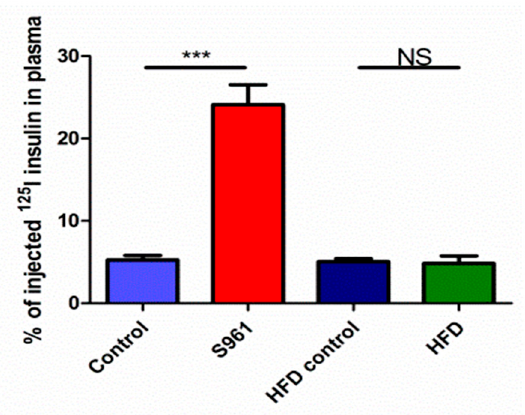
Figure 1. Plasma content of 125 iodine remaining in plasma at five minutes after injection in animal studied under protocol 1 (left two bars) and protocol 2 (right two bars). *** Indicates p value less than 0.001 unpaired t-test.